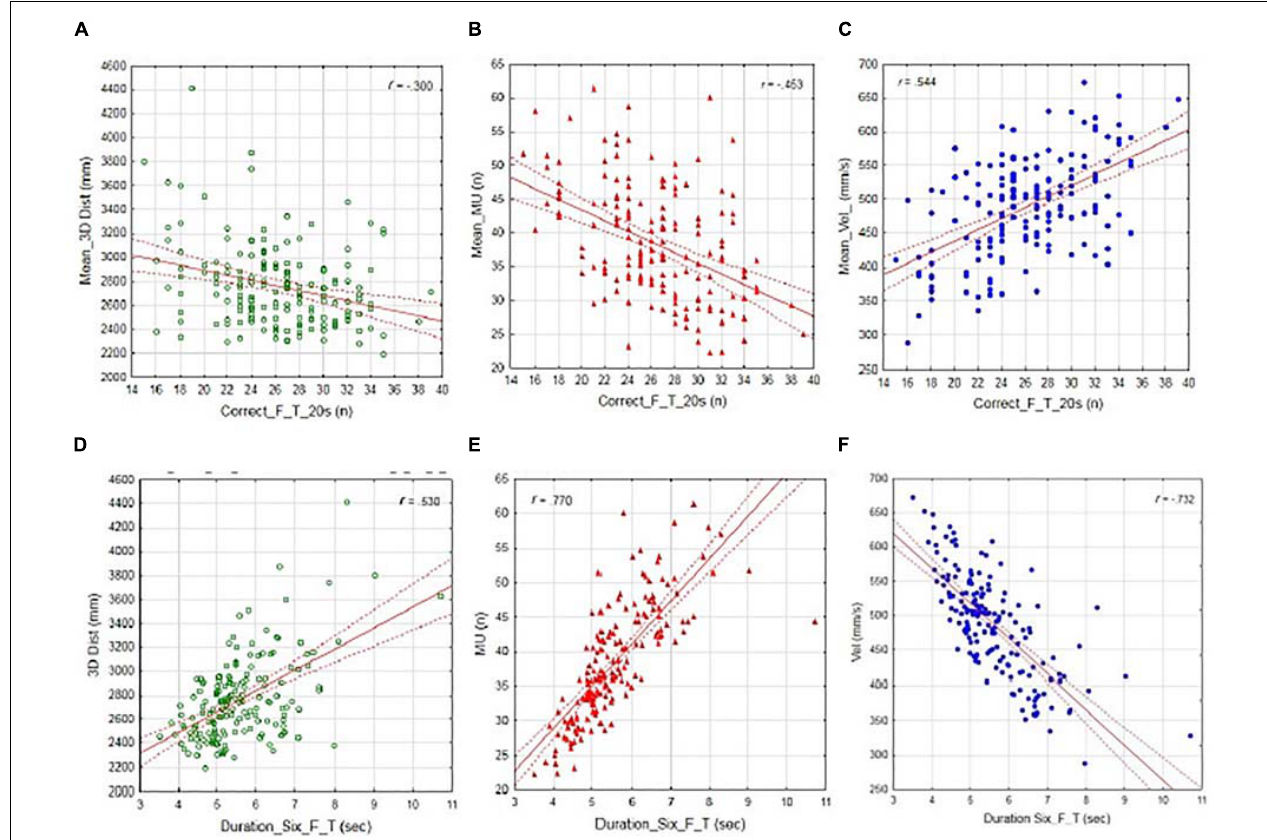
FIGURE 4 | Scatter plots of the relationship between the two respective stepping performance variables: mean number of correct taps during 20 s (A–C) ; mean duration of the first six taps (D–F) , and the kinematic variables: 3D distance, number of MUs, and average velocity. The dotted lines represent 95% confidence